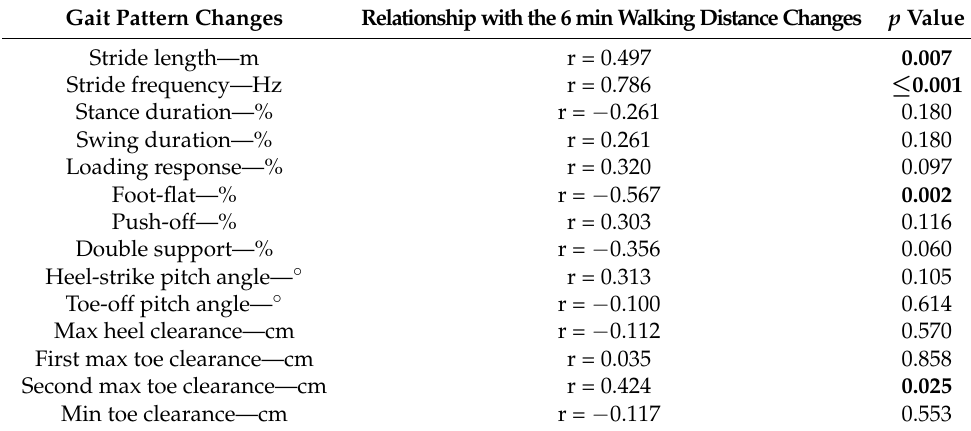
Table 5. Relationship between spatiotemporal gait and foot kinematics changes during pain-free walking condition and changes in 6 min walking distance following supervised exercise